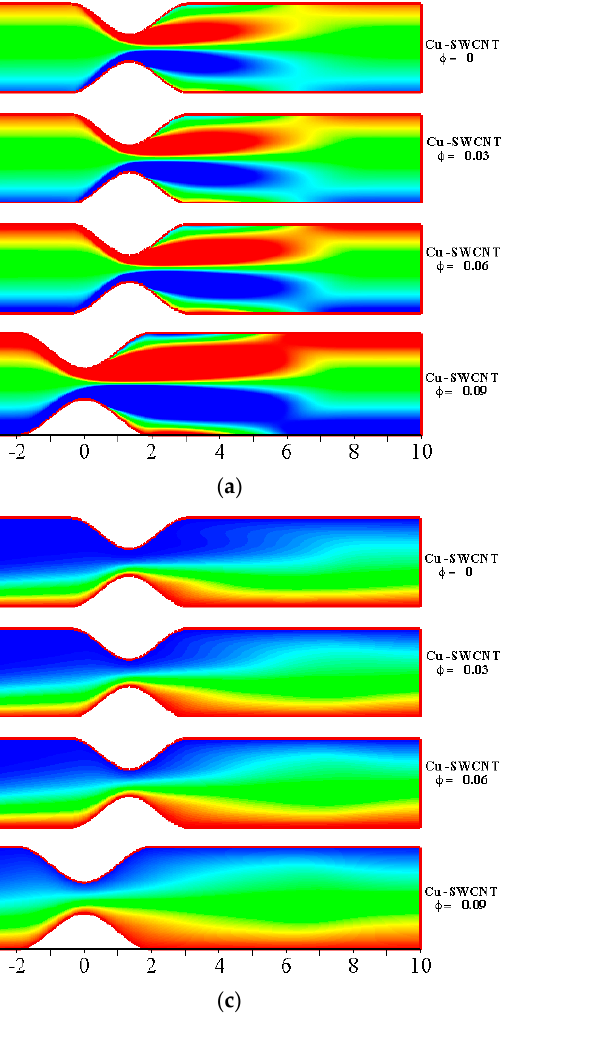
Figure 17. The impact of HNF on ( a ) vorticity, ( b ) streamlines, ( c ) temperature distributions, and ( d ) concentration profile for distinct values of 𝜙 with 𝑅𝑒 = 800 , 𝑀 = 5 , 𝑆𝑡 = 0.02 , and 𝑅𝑑 = 0.2 , at the maximum flow rate ( 𝑡 = 0.25 ).